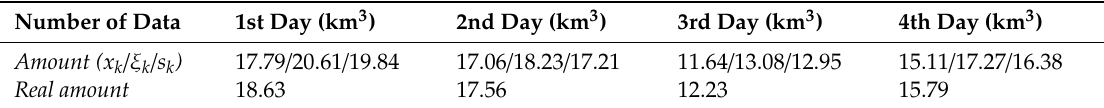
Table 3. Evaluation of SC by total